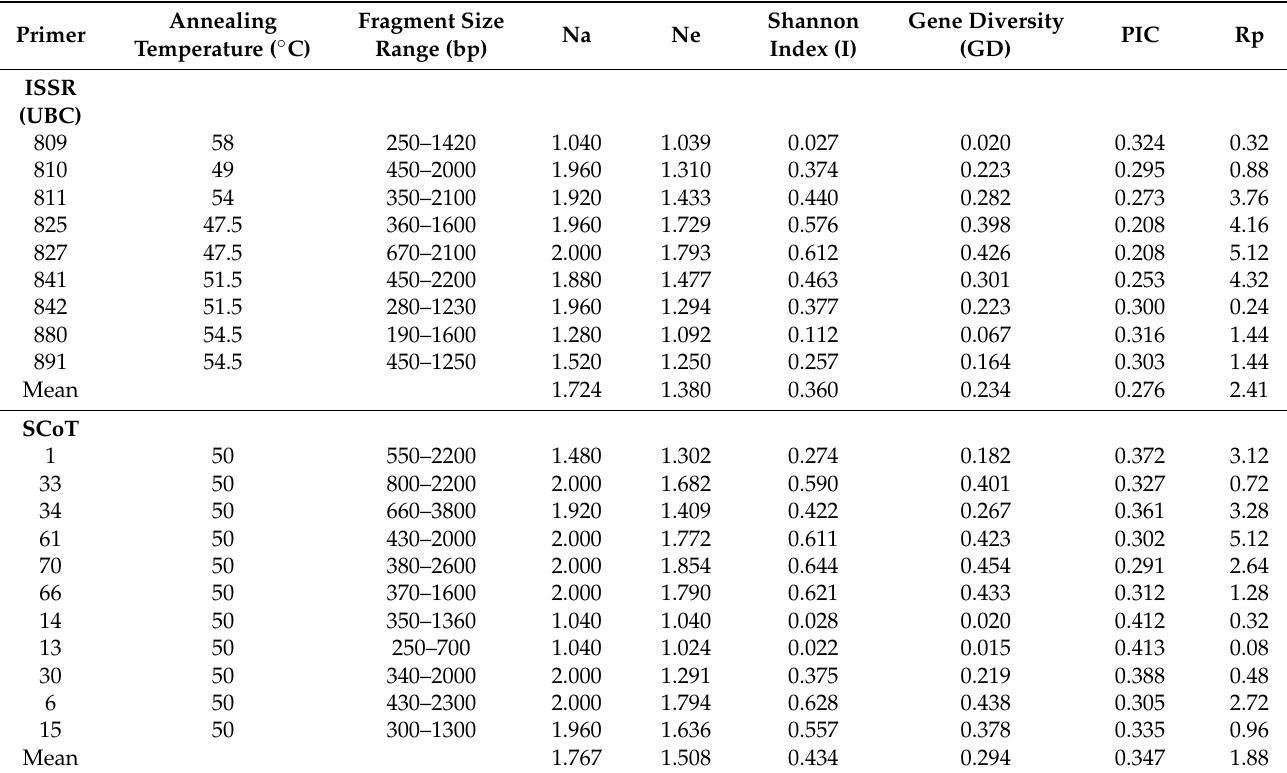
Table 5. Details of ISSR and SCoT primers used, number of different alleles (Na), number of effective alleles (Ne), Shannon’s Information Index (I), gene diversity (GD), polymorphism information content (PIC) and resolving power (Rp) in 26 pomegranate